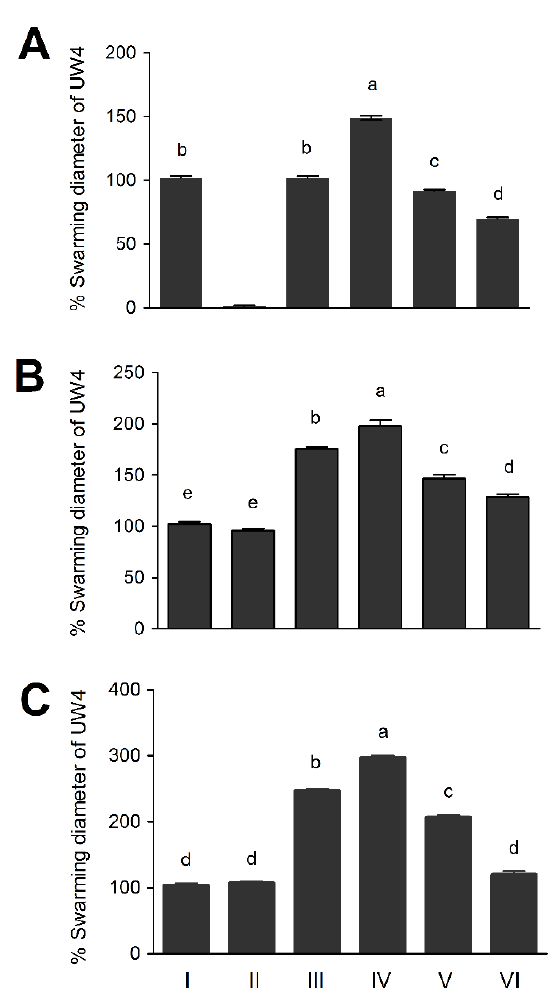
Figure 3. The chemotaxis response of Pseudomonas sp. UW4 and derivative strains to ACC ( A ), arginine ( B ) or succinic acid ( C ). Note: Same as Figure1.